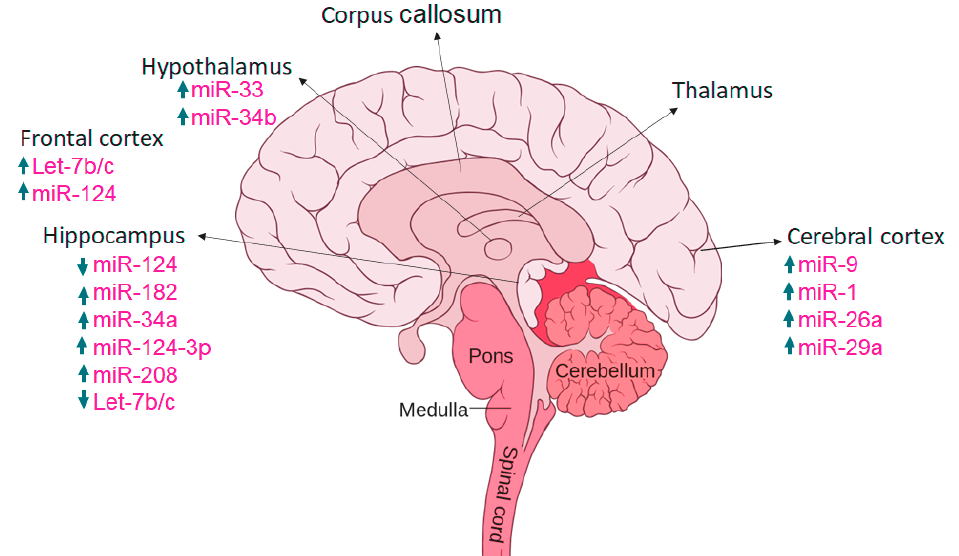
Figure 5. Expression of miRs in various brain regions, with arrows up and down indicating increased and decreased expression.